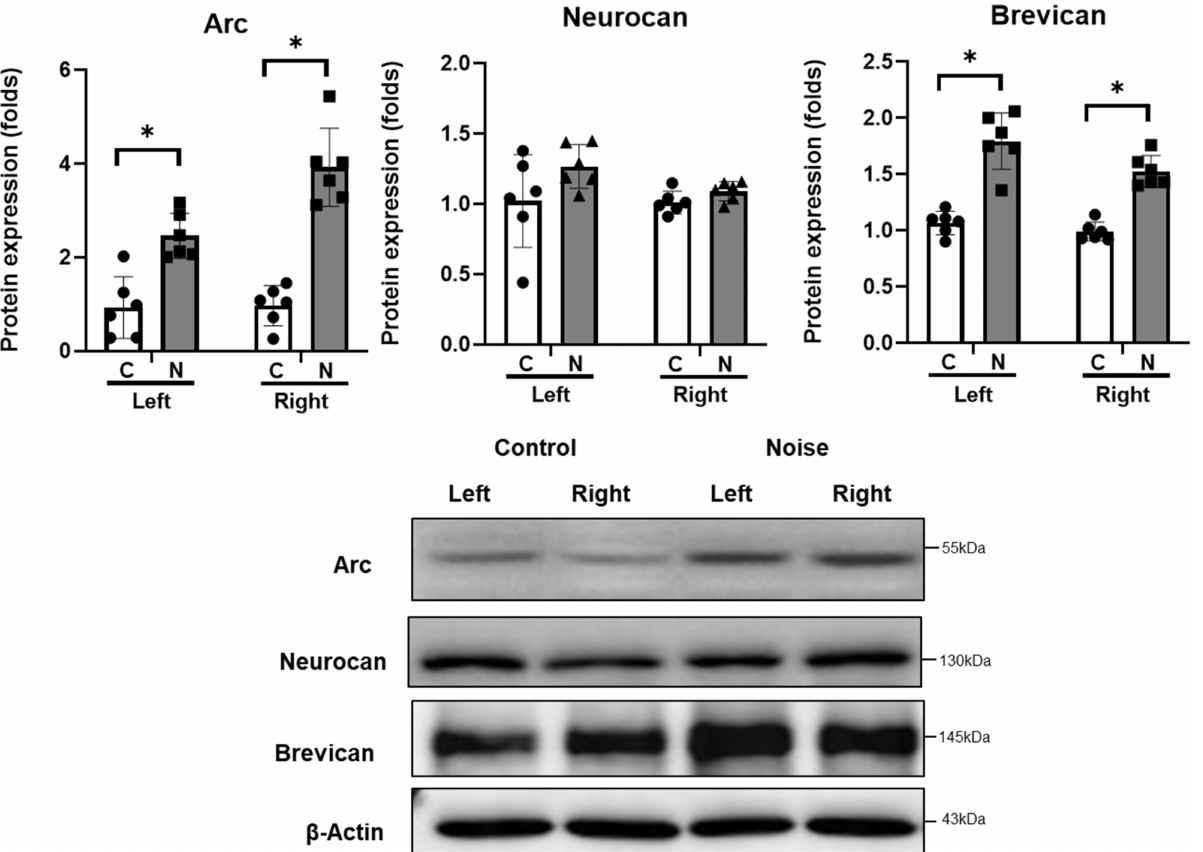
Figure 3. Arc, neurocan, and brevican expression in the cochlear nuclei after noise exposure ( n = 6 per group). Arc and brevican expression was increased in the noise-exposed group (* p < 0.05; unpaired t -test between control and noise-exposed rats; C: control rats; N: noise rats).